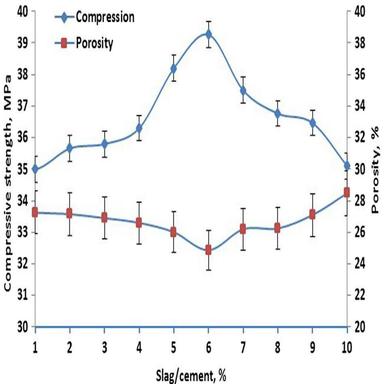
Solidified cement pastes mixed with extended ratios of iron slag for proper strength.